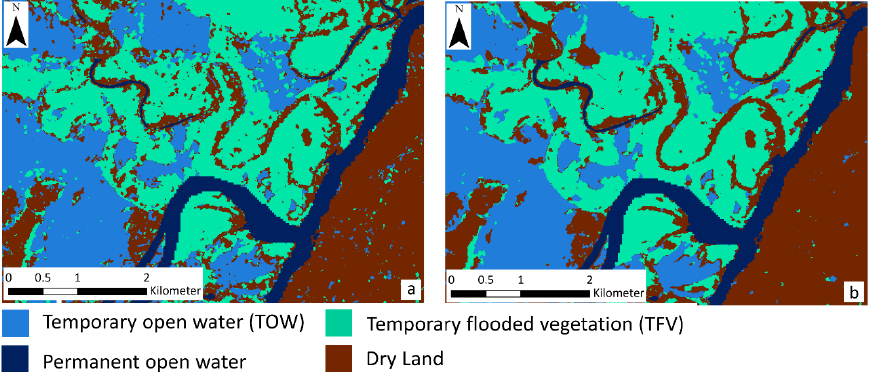
Figure 9. Pixel-based classification result ( a ) and object-based classification result ( b ) for the study area in Namibia.